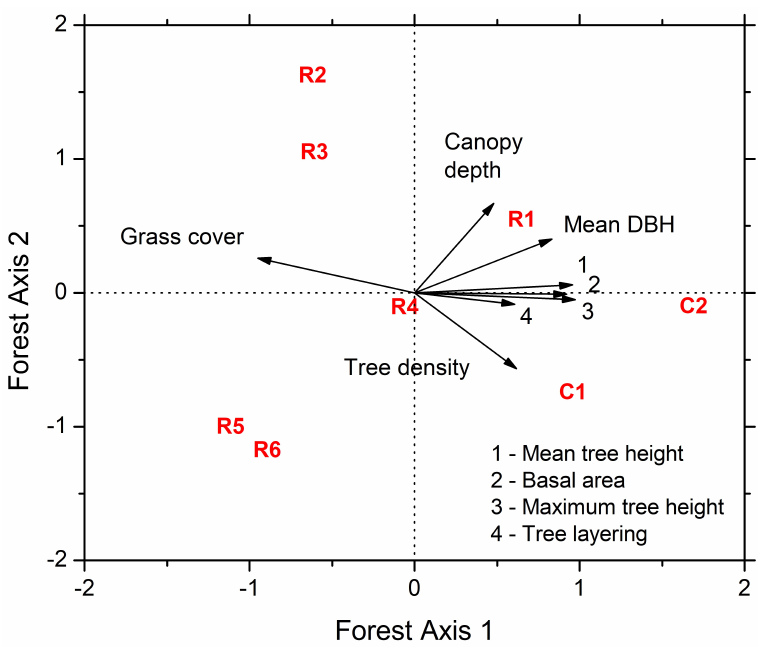
Figure 1. Results of principal component analysis of reference (C1 and C2) and under restoration (R1–R6) sites in relation to forest structure variables.